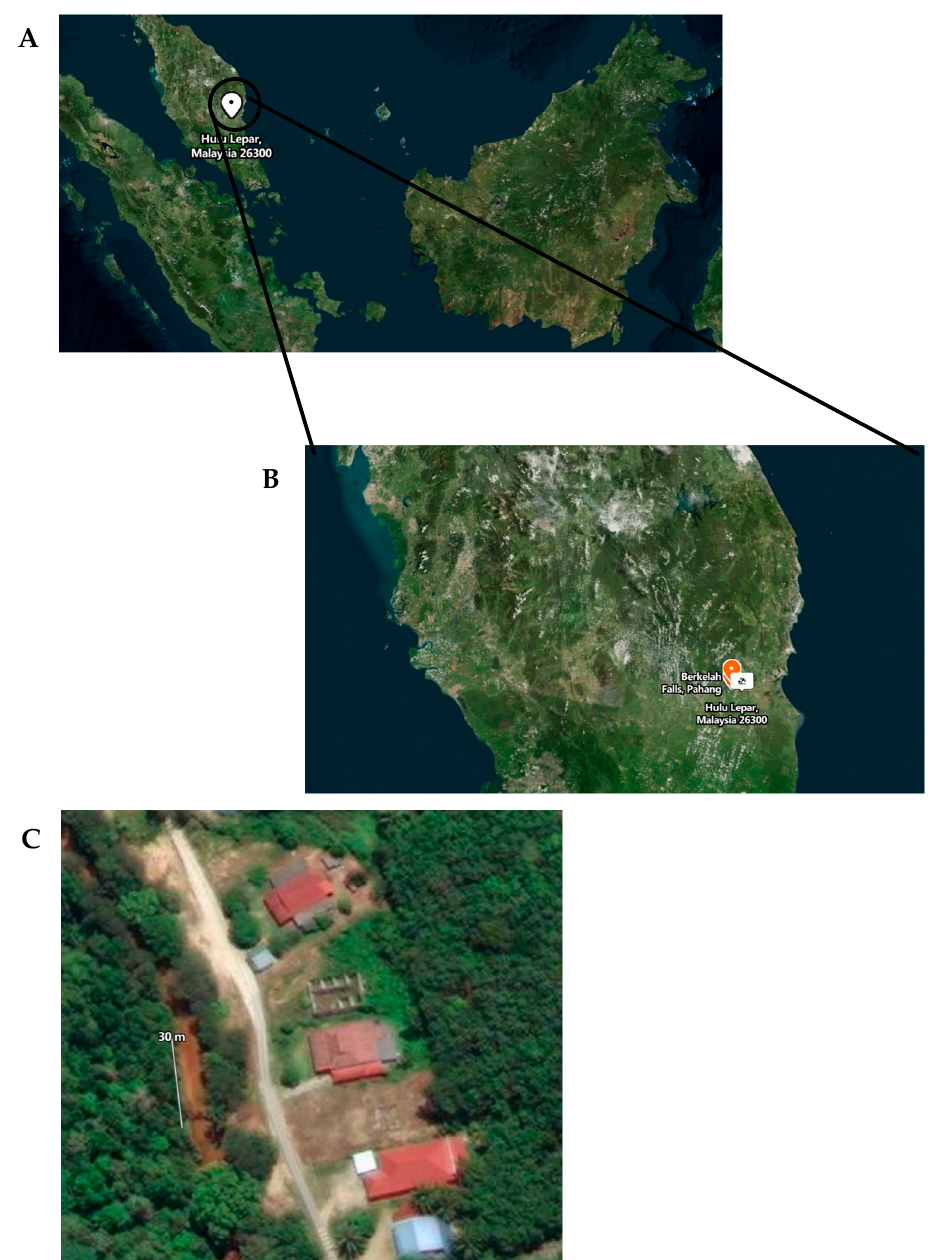
Figure 3. The pictures to show the location of Sg. Berkelah. ( A ) Map of Malaysia. ( B ) Location of selected Sg. Berkelah river section. ( C ) The picture of the exact river section of Sg. Berkelah. Source: Google Map